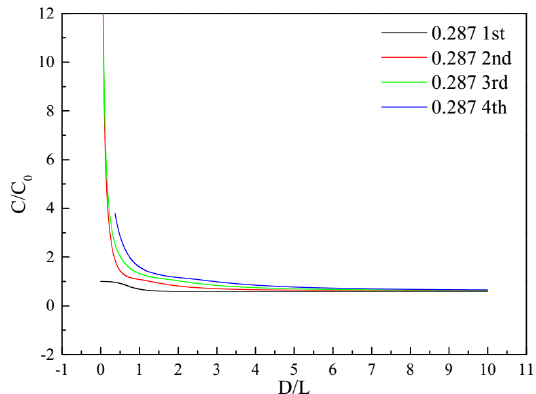
Figure 3. The first to fourth order phase velocity curves of Poisson’s ratio of 0.287 .